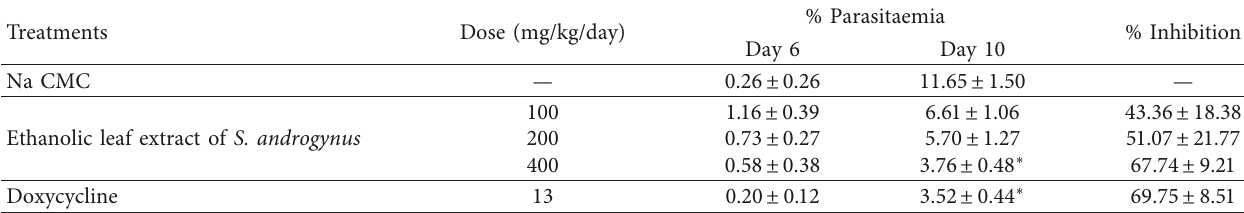
Table 4: Percentages of inhibition of parasite growth in mice infected with P. berghei treated orally by doses of ethanolic leaf extract of S. androgynus for 8 consecutive days before and after infection ( D 0 − D 7 ).